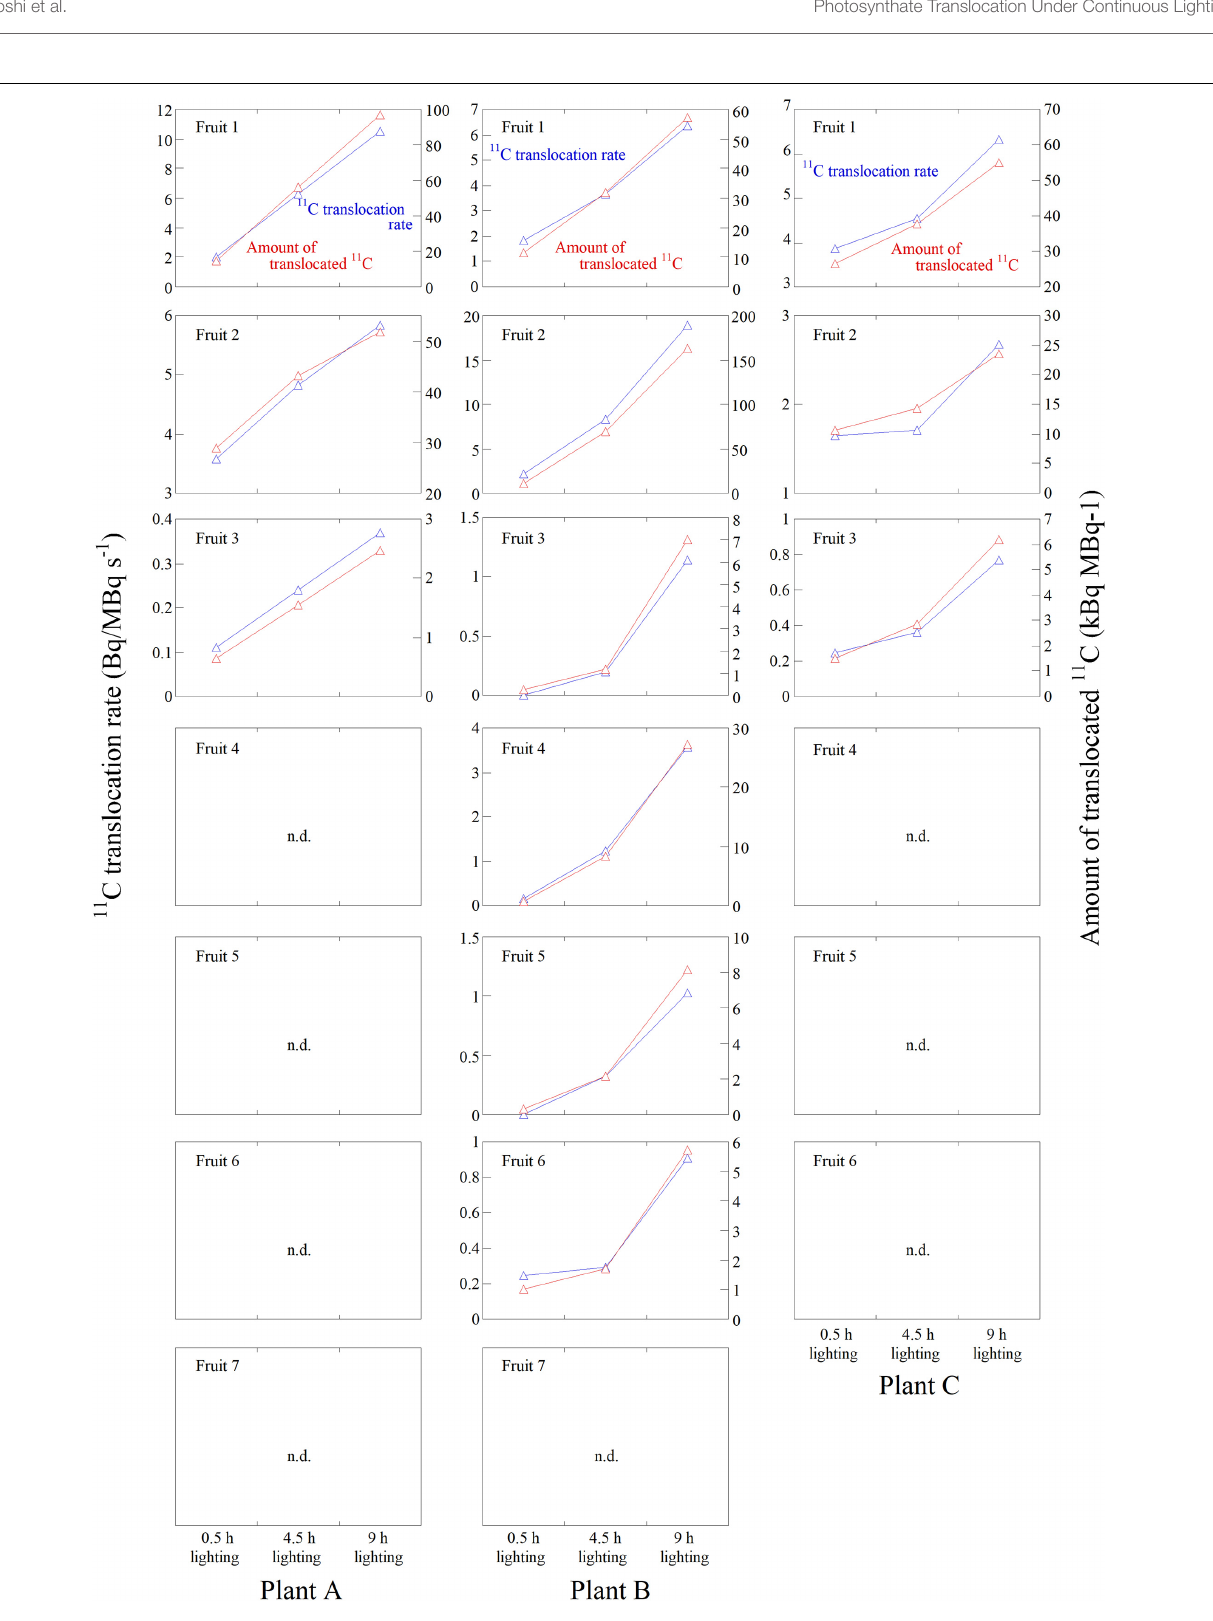
FIGURE 5 | 11 C-photosynthate translocation rate and the amount of 11 C-photosynthates translocated into all fruits in Plants A–C in response to the 0.5-, 4.5-, and 9-h lighting treatments. The data were normalized against the 11 C-radioactivity assimilated by the source leaf during each PETIS imaging experiment. The fruits in which 11 C-photosynthates were not detected are indicated with